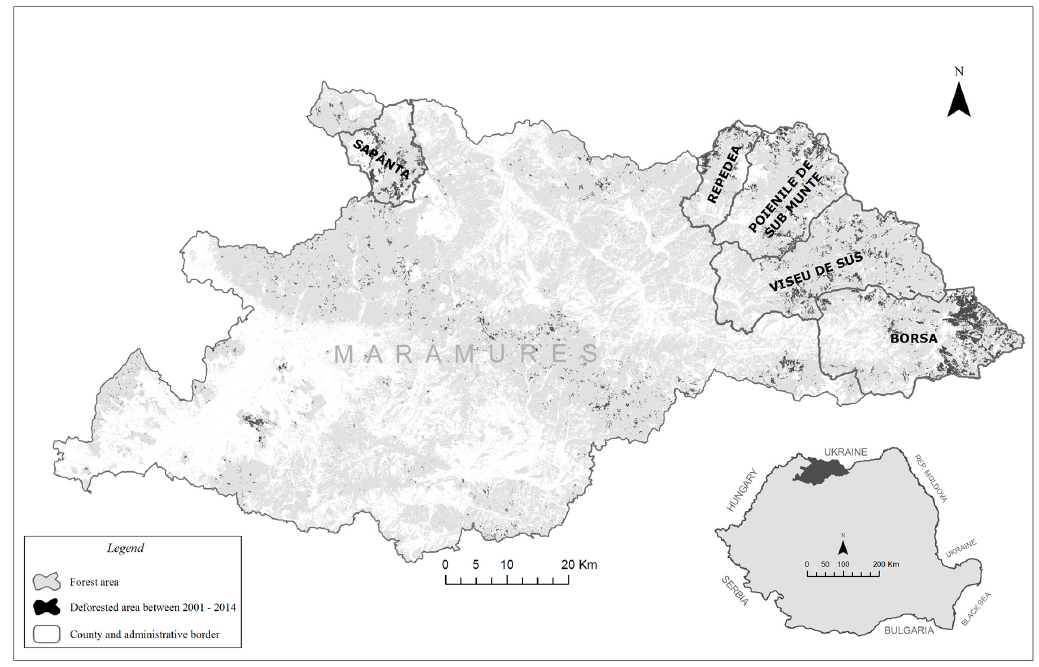
Figure 1. Geographical study area of Maramure ș County and selected territorial administrative units (TAU), located in Northern Romania. Data Source: [29].